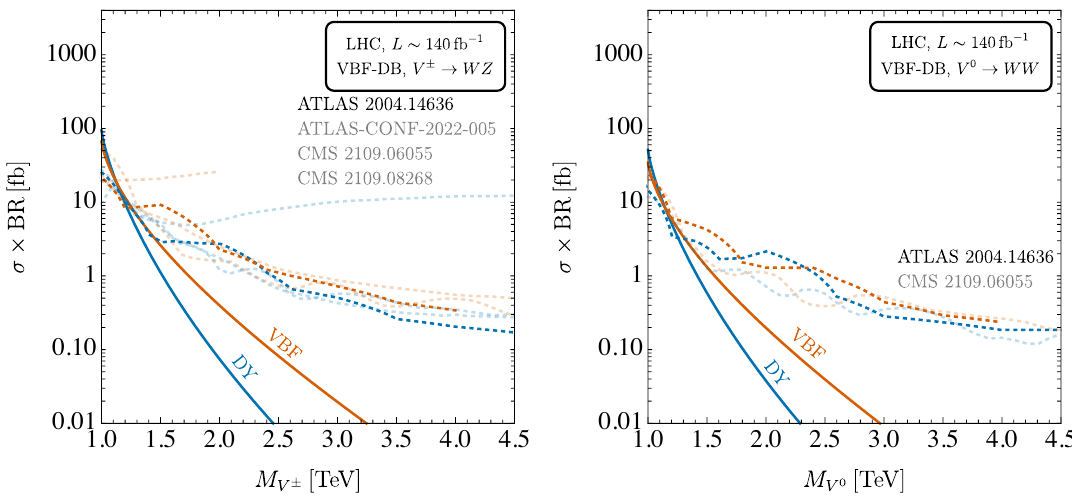
Figure 5 . The DY (blue) and VBF (red) production cross-sections times branching ratio in WZ (left) and WW (right) for the VBF-DB benchmark. The most stringent LHC limits from [35] are shown in bright dotted blue and red, while similar but less constraining searches are shown in the background [34, 43,